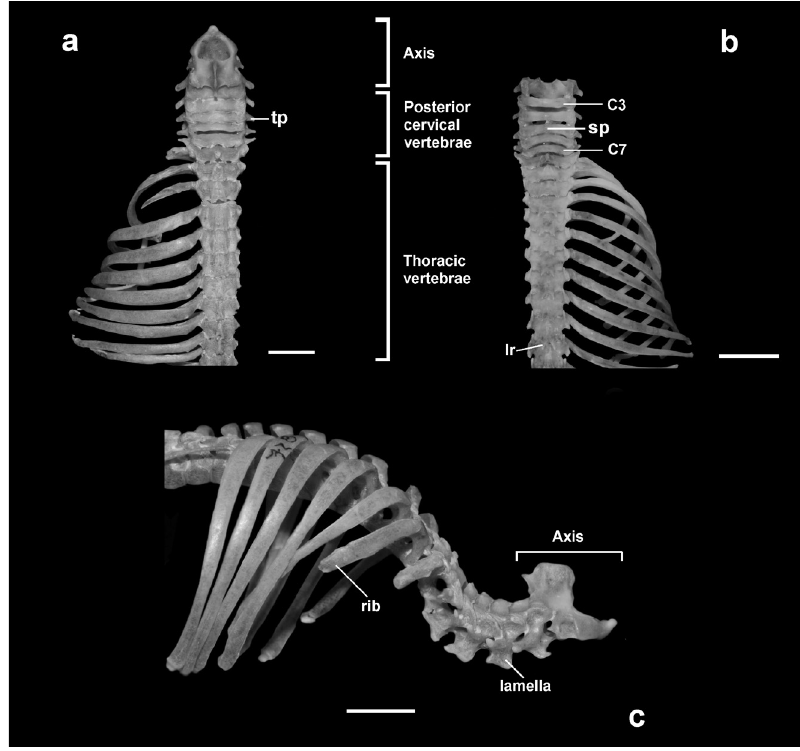
Figure 6 - Dorsal view of cervical and thoracic regions: a . Chrotopterus auritus ; b . Desmodus rotundus . Lateral view of cervical and thoracic regions: c . Chrotopterus auritus . Acronyms: C3: third cervical vertebrae; C7: seventh cervical vertebrae; lr: lateral ridge; sp: spinous process; tp: transverse process. Scale bar represents 5